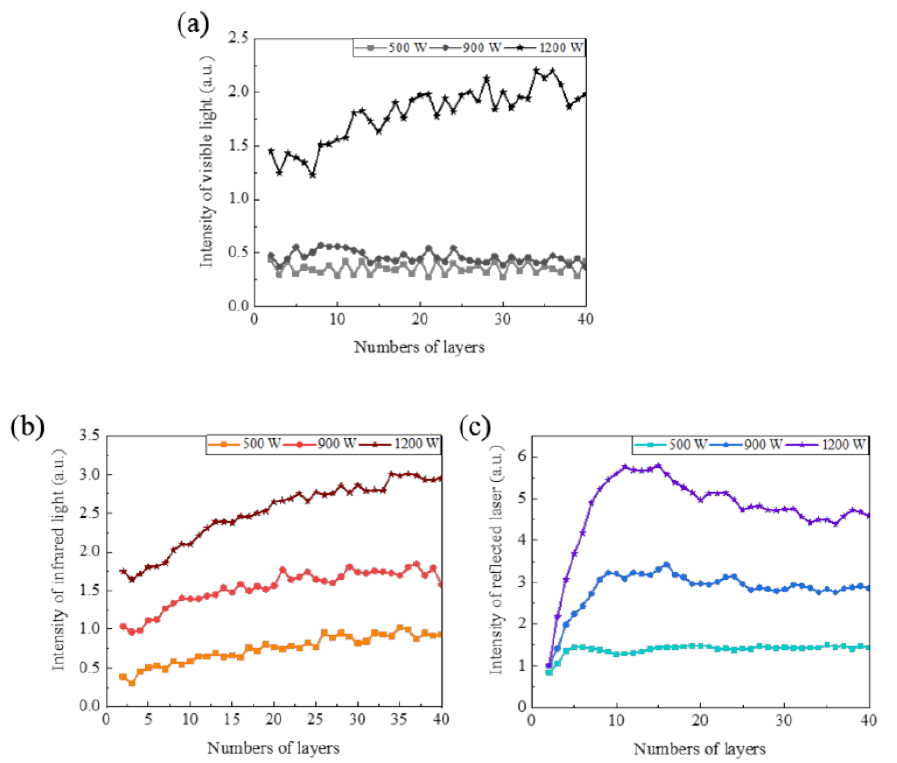
Figure 10. Characteristics of monitoring signals during the LMD process with different laser powers: ( a ) visible light signals, ( b ) infared light signals, ( c ) reflected laser